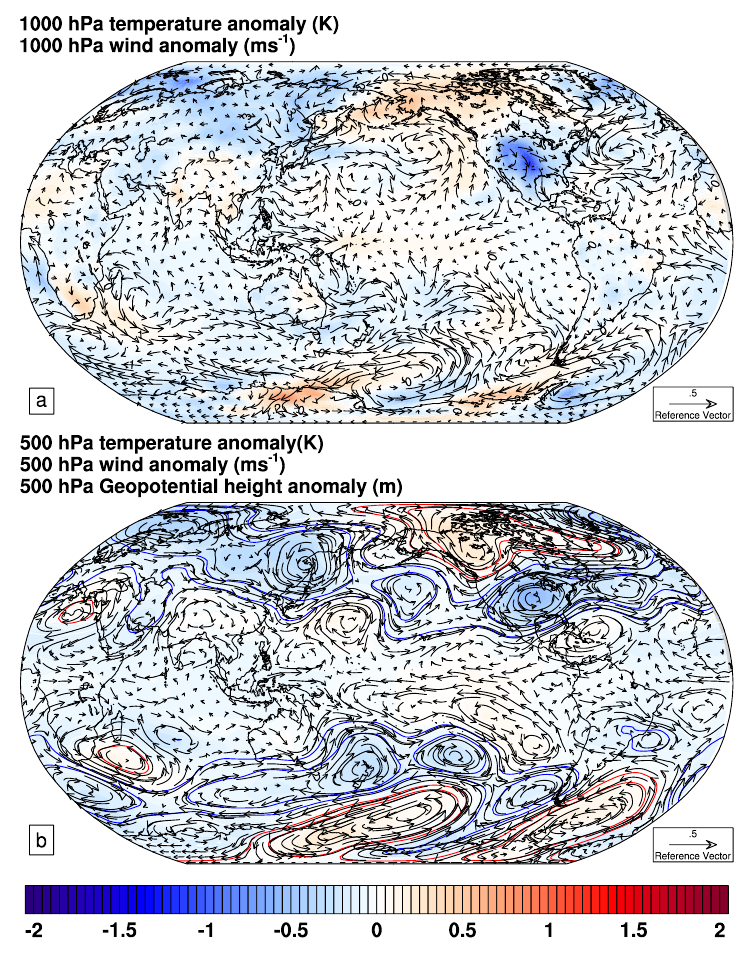
Figure 2. The same as Figure 1 but for: ( a ) 1000hPa air temperature (K) and wind vector (ms − 1 ); and ( b ) 500hPa air temperature (color shades), wind vector (ms − 1 ), geopotential height (m, contours from − 4 to 4 by 2) and wind vector